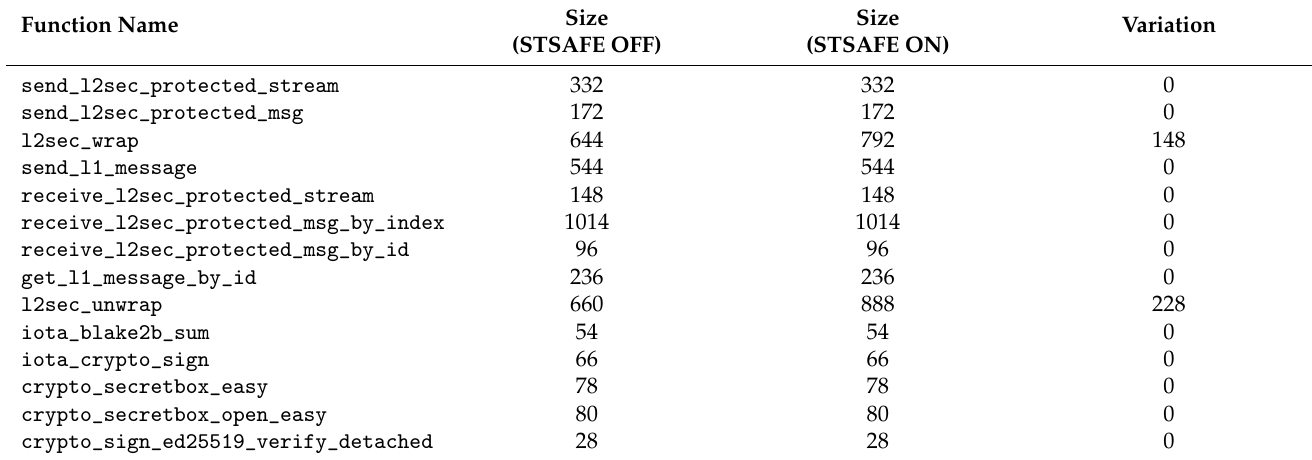
Table 4. Code size of significant functions for L2Sec implementation. All sizes are expressed in